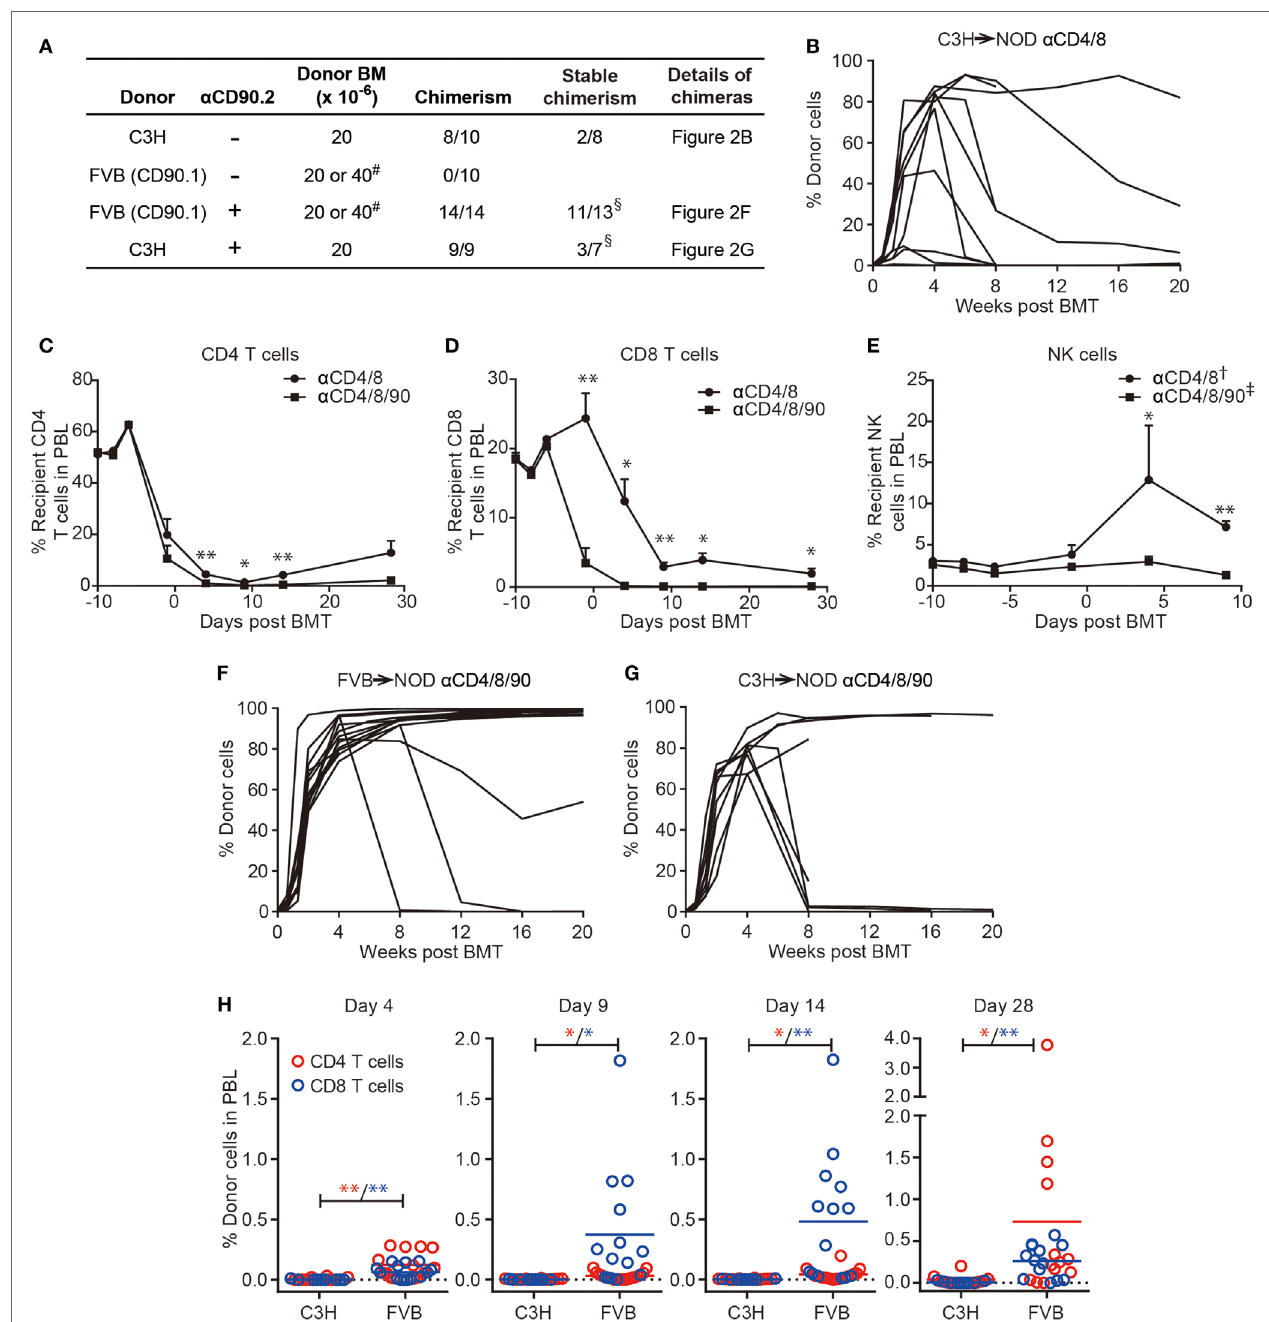
FigUre 2 | Robust T cell depletion in non-obese diabetic (NOD) mice preconditioned with donor-specific transfusion (DST)-cyclophosphamide (CYP) allows chimerism using fully allogeneic donor hematopoietic cells. (a) NOD recipients were conditioned with DST (day − 10), CYP (day − 8), a combination of T cell depletion monoclonal antibodies (mAbs) (anti-CD4/8 ± anti-CD90, days − 6, − 1, 4, 9, 14; “-” indicates no injection), busulfan (day − 1), and bone marrow cells (BMC) (day 0, 20, or 40 × 10 6 ). # two recipients from each group given 40 × 10 6 BMC, the remainder received 20 × 10 6 ; cells were from the same donor strain as the DST. The success of chimerism was determined at 4 weeks postbone marrow transplantation. § One FVB → NOD and two C3H → NOD chimeras were excluded as they were found dead prior to analysis of the stability of chimerism. (B,F,g) Shown are the proportions of donor cells in lymphocyte gate in peripheral blood lymphocytes (PBL) over time. (c–e) PBL were harvested before each treatment to evaluate the CD4, CD8 T cell, and NK cell components in FVB → NOD recipients conditioned with anti-CD4/8 or anti-CD4/8/90 mAbs. Shown are percentages of recipient CD4, CD8 T cell, and NK cells in the lymphocyte gate (mean ± SEM). NOD recipients were treated with anti-CD4/8 ( n = 10; † n = 2) or anti-CD4/8/90 ( n = 14; ‡ n = 6) mAbs. (h) PBL were harvested at the indicated time points to evaluate the donor CD4 and CD8 T cells in C3H → NOD or FVB → NOD recipients conditioned with anti-CD4/8/90 mAbs. Shown are percentages of donor CD4 and CD8 T cell in the lymphocyte gate (mean). Data were pooled from at least two independent experiments. * p < 0.05, ** p < 0.005, Student’s t -test with Welch’s correction when variances were significantly different.